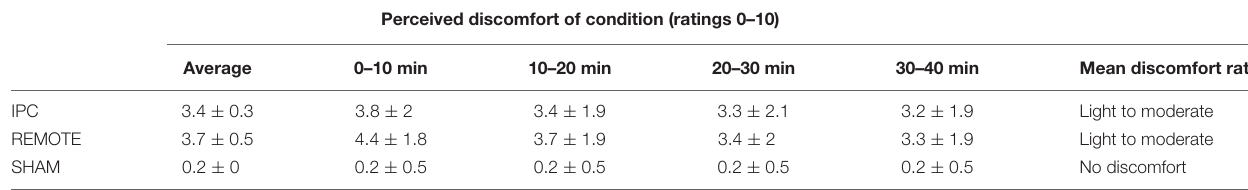
TABLE 4 | Mean ± SD values for perceived discomfort of ischemic preconditioning (IPC) and SHAM